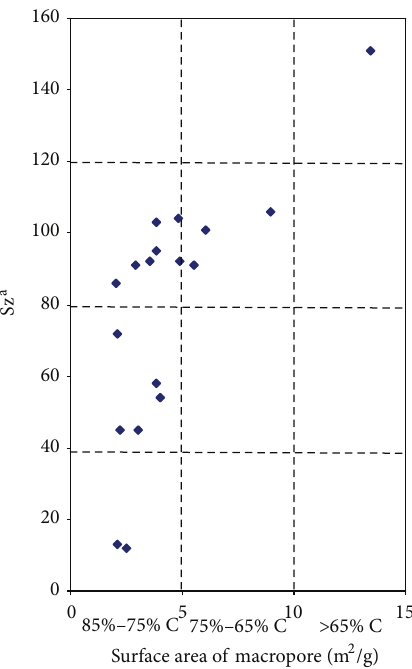
Figure 2: Value of spontaneous combustion index Sz a function of micropore volume.